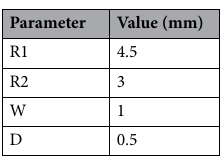
Table 2. Geometrical parameters of the square